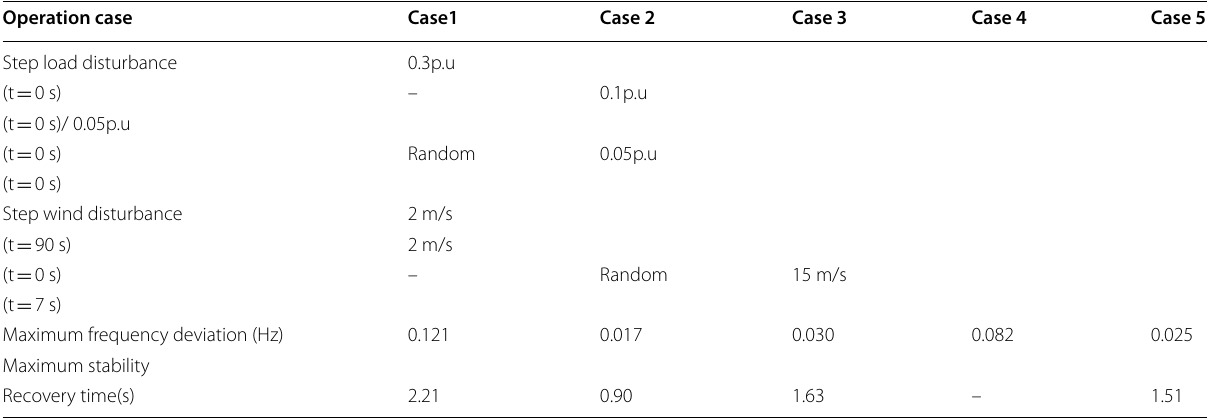
Table 3 The input and output parameters in different cases Operation